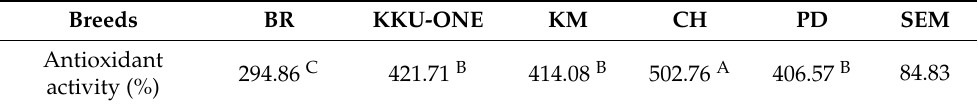
Table 3. Antioxidant effect of dipeptide-rich chicken breast extract of TNC, TSC, and TNC crossbred animals. Breeds BR KKU-ONE Antioxidant activity (%) A,B,C represent the level of significance of the differences among the genotypes ( p < 0.01). PD = Pradu Hang Dam Mor Kor 55 (100% Thai native), CH = Chee KKU 12 (100% Thai native), KM = Khai Mook E-san (50% Thai native), and KKU-ONE (25% Thai native) compared to BR = commercial broiler